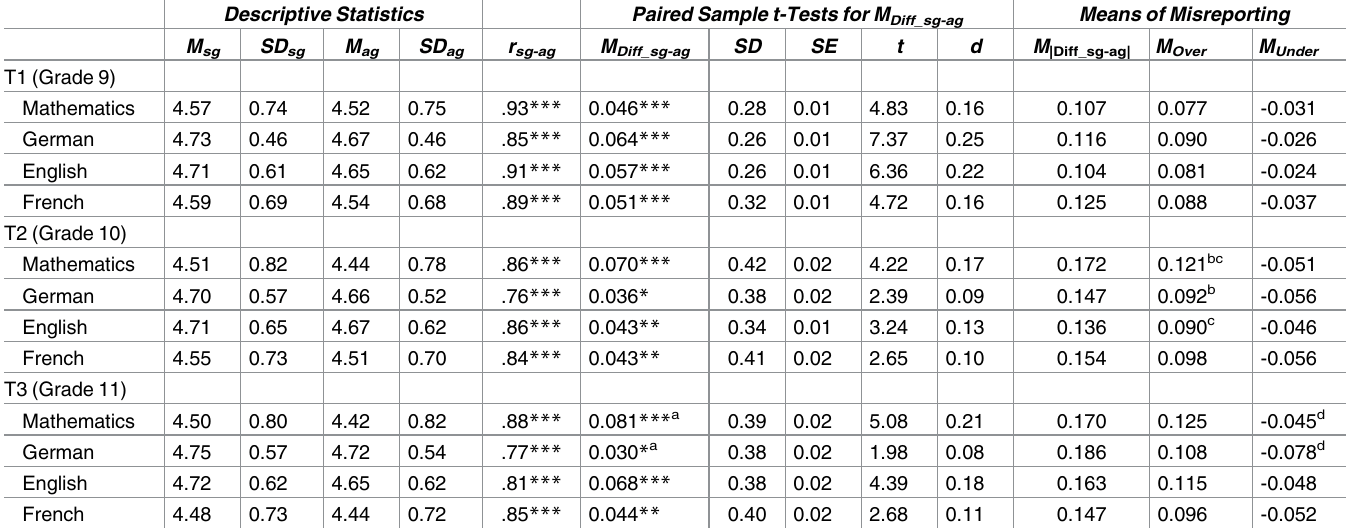
Table 1. Descriptivestatistics,correlations, T-Test for the difference between self-reported and actual grades, and means of misreporting. Descriptive